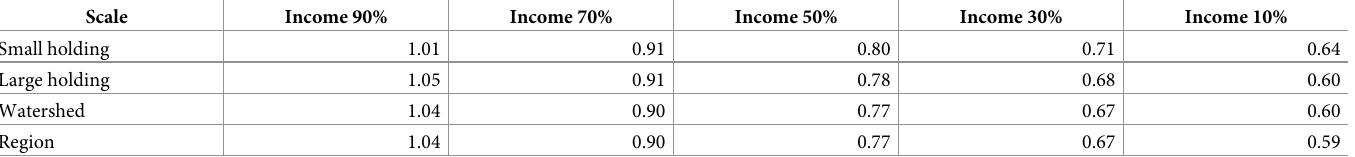
Table 3. Among-stand variation in deadwood availability. Coefficients of variation in the values of deadwood availability across stands at different harvest income requirements (90%, 70%, 50%, 30%, or 10% of its maximal value). Scale Small holding Large holding